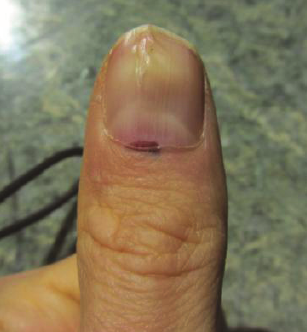
Figure 1. Subungual melanoma of the left thumb. Note pigmentation of the nail fold and faint pigmentation and abnormality of the nail